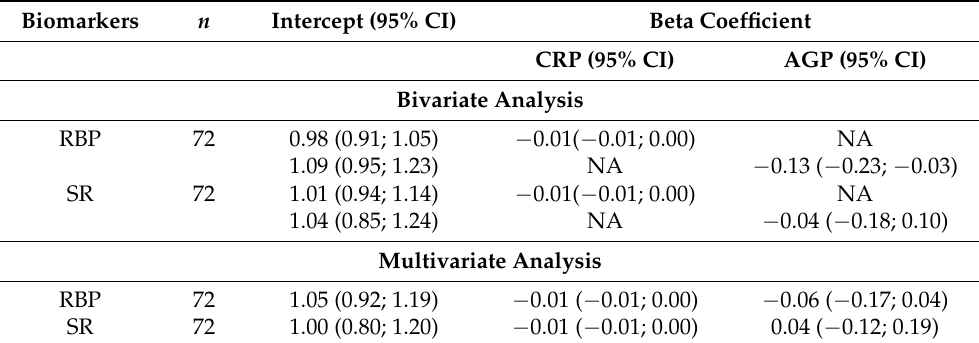
Table 2. Associations between the vitamin A biomarkers and the inflammatory markers to test for effects of inflammation in the sub-sample. Biomarkers n Intercept (95% CI) Beta